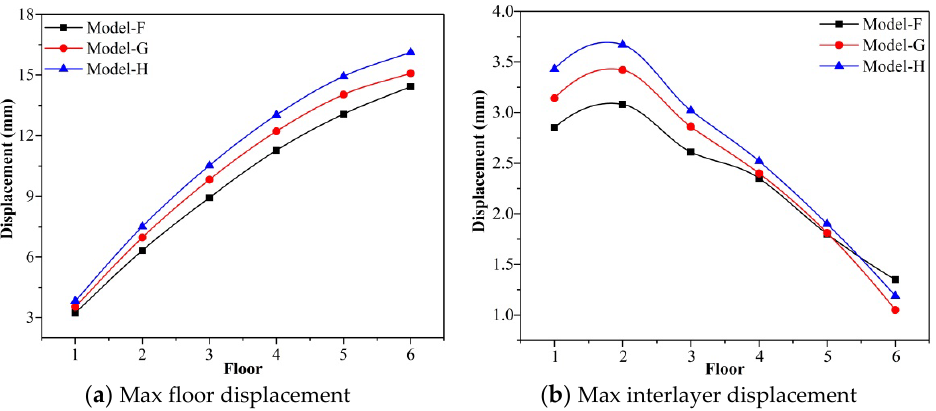
Figure 18. The floor displacement and interlayer displacement in the X-direction. Under the horizontal earthquake action in the Y-direction, the max floor displacements of the models in the Y-direction were 15.61 mm, 14.53 mm, and 13.68 mm, respectively (Figure 19). Model H was 7.4% larger than model G and 14.4% larger than model F. The maximum interlayer displacement in the Y-direction also appeared in the second layer, model H was 3.19 mm, and the interlayer displacement angle was 1/1231. Model G was 2.95 mm, and the interlayer displacement angle was 1/1322. The model F was 2.85 mm, and the inter-story drift angle was 1/1368, which was less than 1/550 and met the requirements of the code. The results showed that the maximum interlayer displacement of model H in the Y-direction was greater than that of model G under horizontal seismic action. This indicates that the lateral stiffness of the structure will be reduced when the stairs are symmetrically arranged.